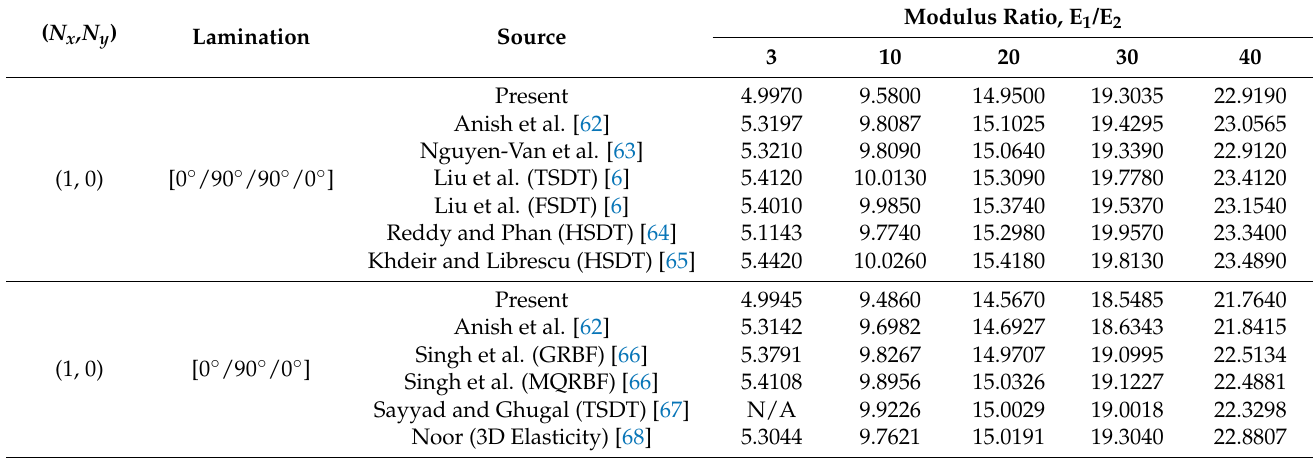
Table 4. Comparison of nondimensional buckling loads, N = N cr α 2 / E 2 h 3 , for simply supported cross-ply laminated